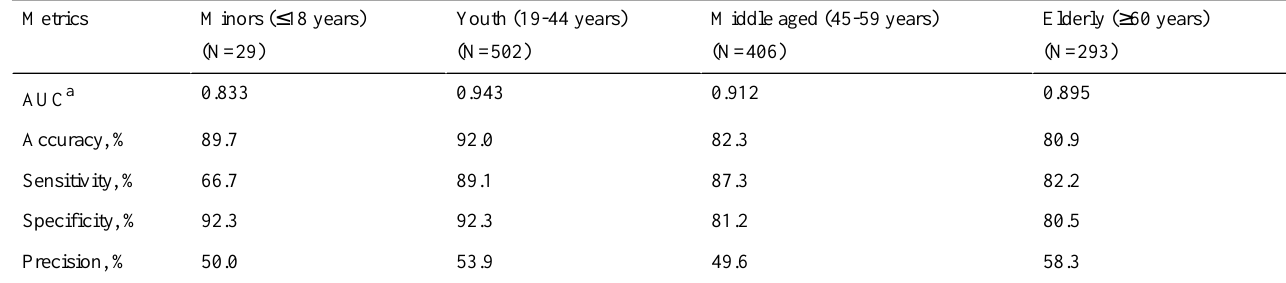
Table 4. Model performance of the composite outcome prediction model in different age